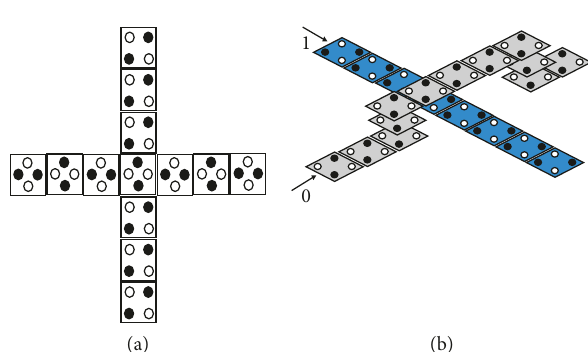
Figure 5: QCA clock zones.